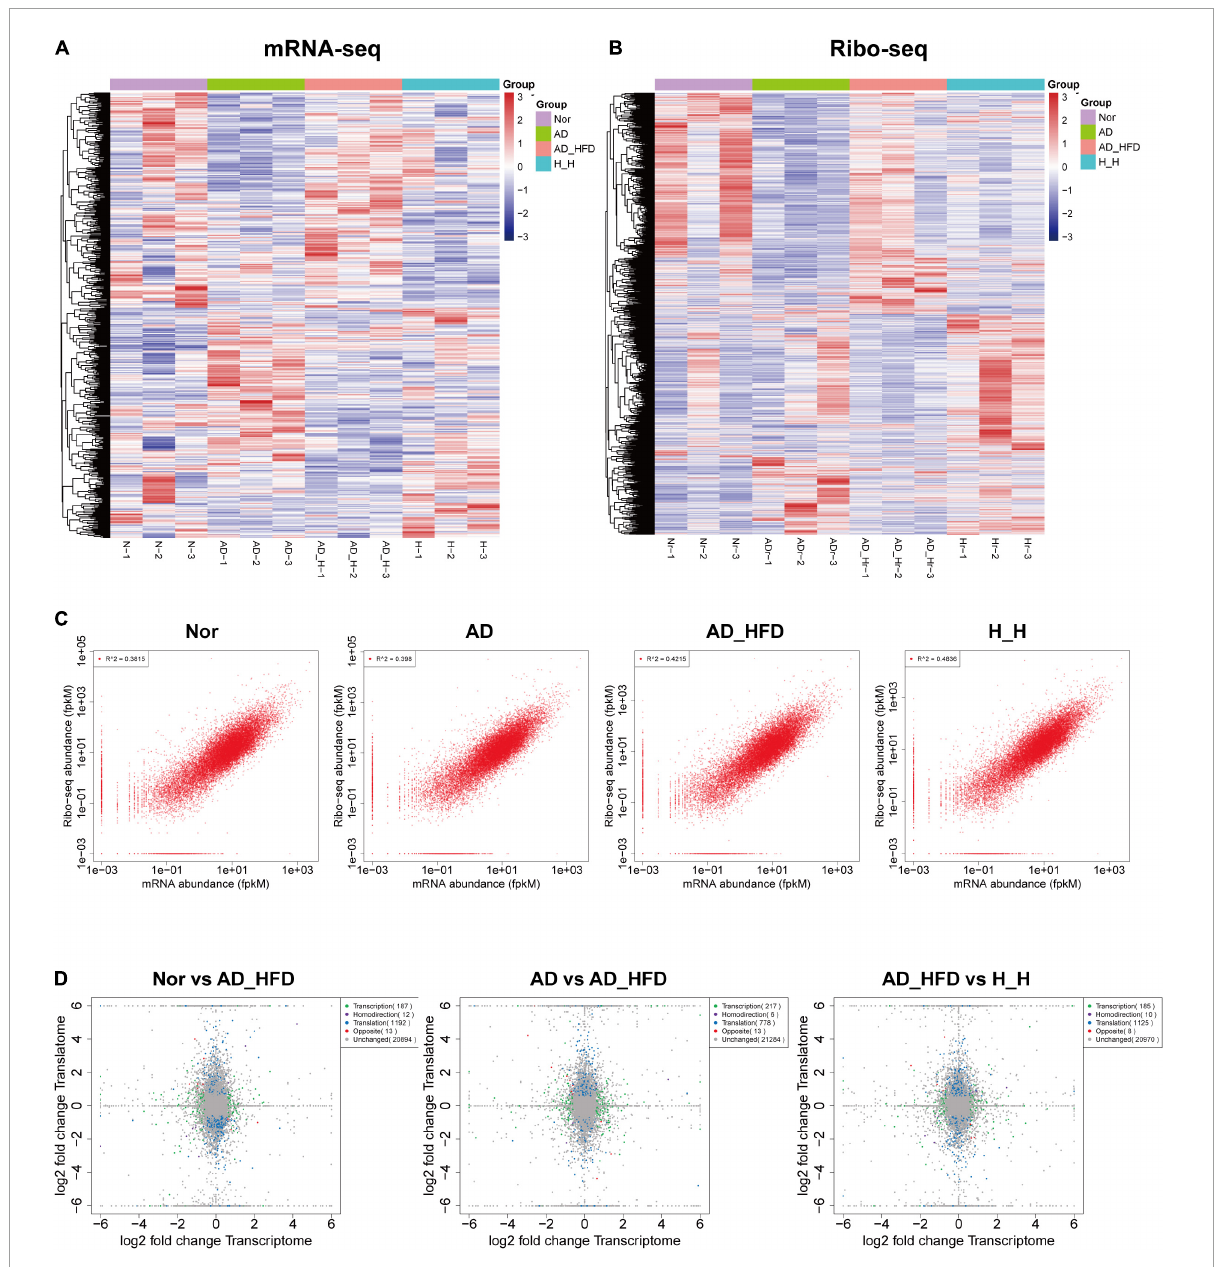
FIGURE2 Overview of genes identified by transcriptome and translatome. Heatmap of cluster analysis of DEGs in the transcriptome (A) and translatome (B) . N-1, N-2, and N-3 represent the Nor group biological repetition. AD-1, AD-2, and AD-3 represent the AD group biological repetition. AD_H-1, AD_H-2, and AD_H-3 represent the AD_HFD group biological repetition. Blue represents the lowest and red represents the highest. (C) Scatter plot of transcriptome and translatome in four groups. (D) Quadrant diagram of the fold change at transcriptional and translational